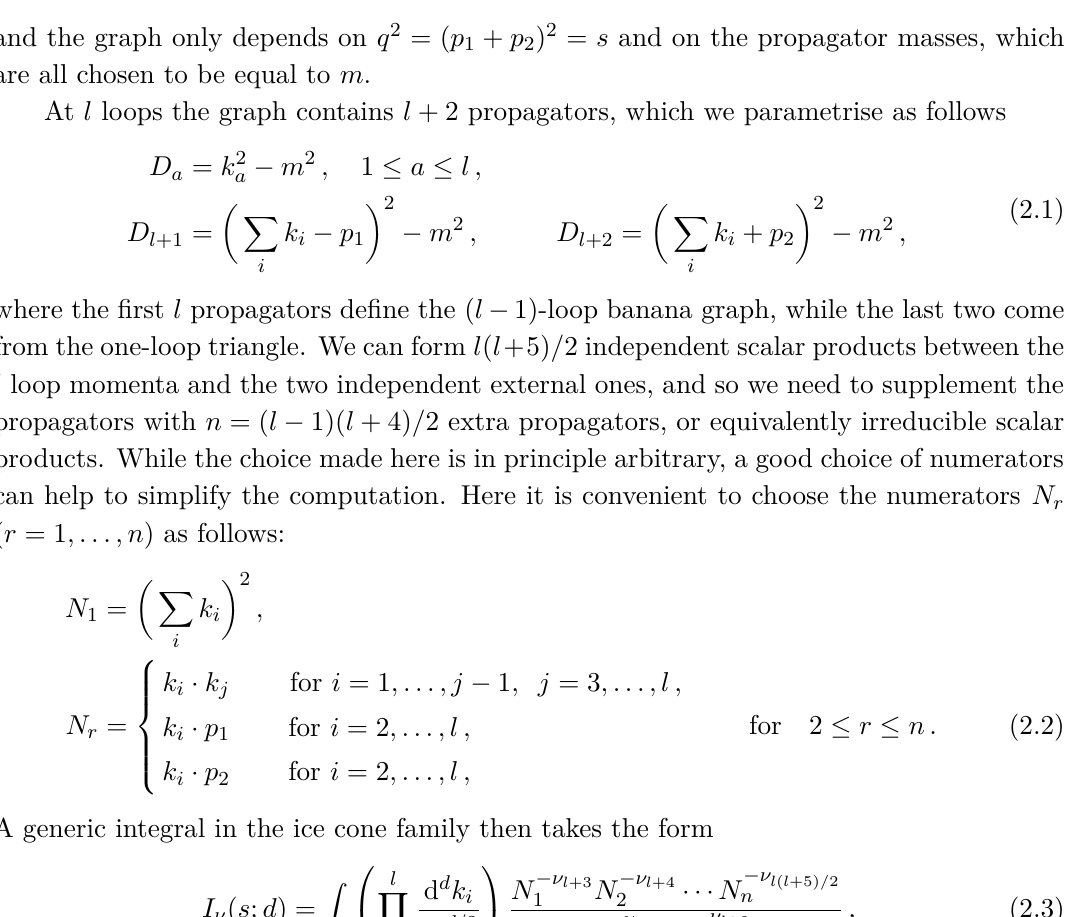
Figure 1 . The l -loop equal-mass ice cone graph build up from a ( l − 1) -loop banana graph and a one-loop